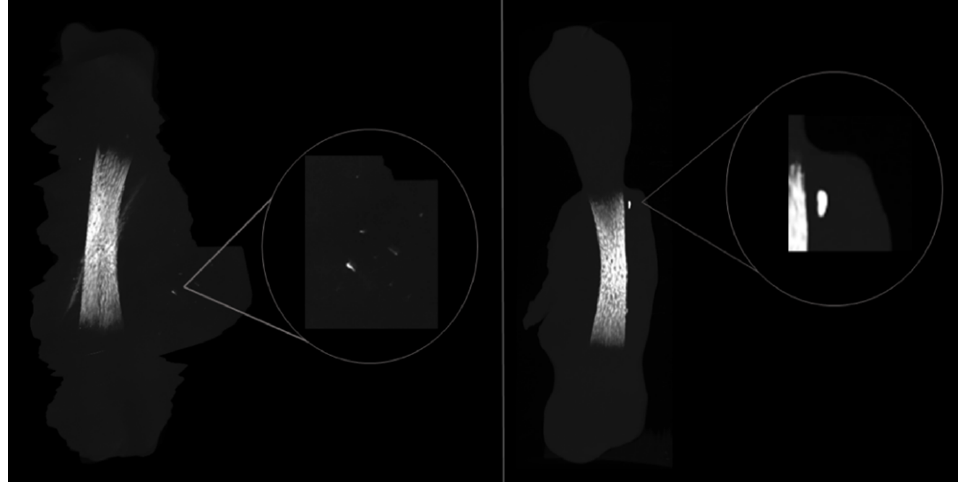
Figure 4. Representative three-dimensional microcomputed images of bone nodules found across the L-PRF membrane in the direct-contact experimental group, emphasising the osteogenic potential of the L-PRF membrane.